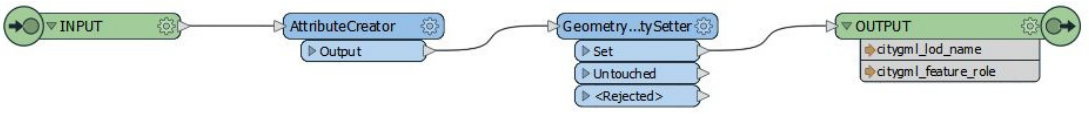
Figure 18. “CityGMLGeometrySetter” custom transformer workflow. Table 4. Corresponces beetween IFC and CityGML features and geometries.